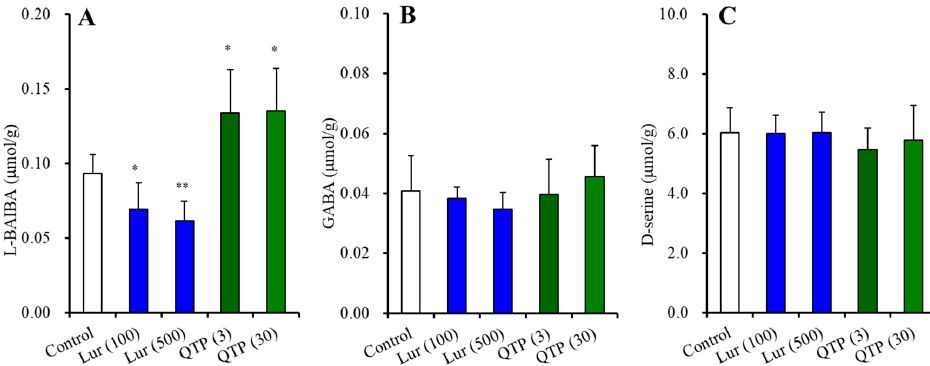
Figure 7. Effects of chronically exposure of lurasidone (Lur: 100 and 500 nM for 14 d), quetiapine (QTP: 3 and 30 µ M for 14 d) on intracellular levels of L-BAIBA ( A ), GABA ( B ), and D-serine ( C ) in the astrocytes. Ordinate: mean ± SD ( n = 6) of levels of L-BAIBA, GABA and D-serine in the astrocytes ( µ mol/g protein). *: p < 0.05, **: p < 0.01: relative to control by ANOVA with Tukey’s post hoc test.